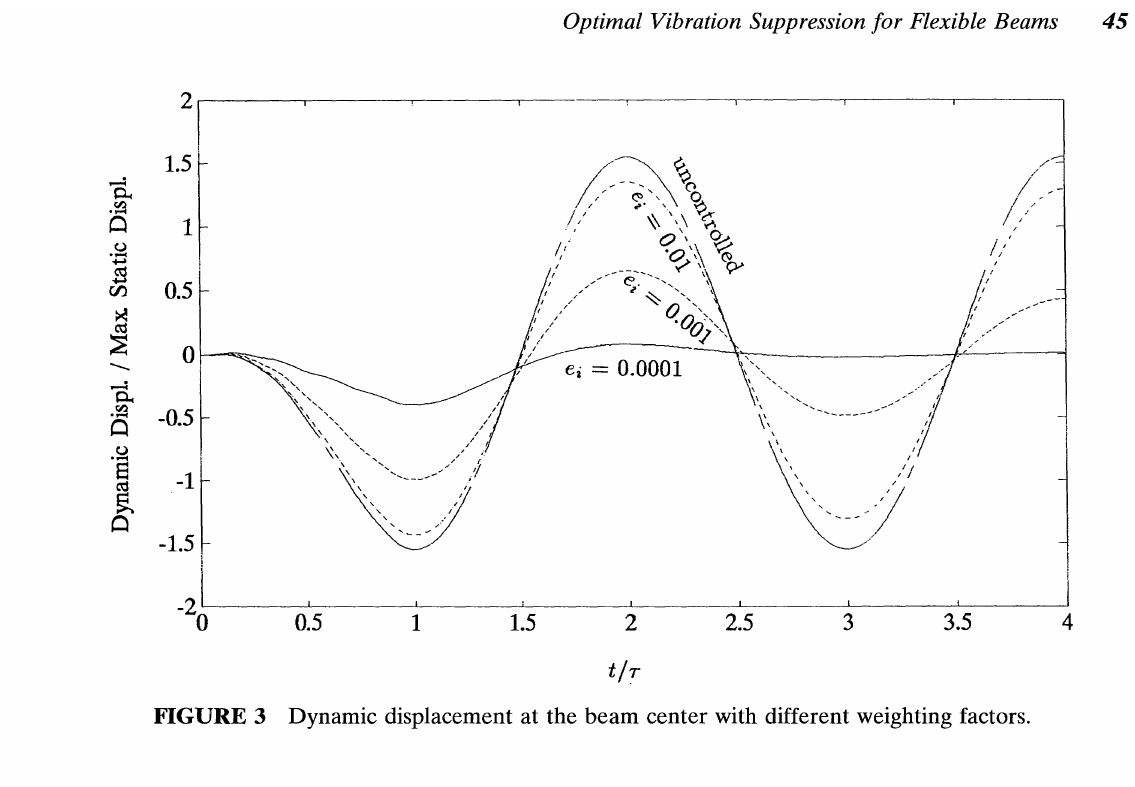
FIGURE 3 Dynamic displacement at the beam center with different weighting